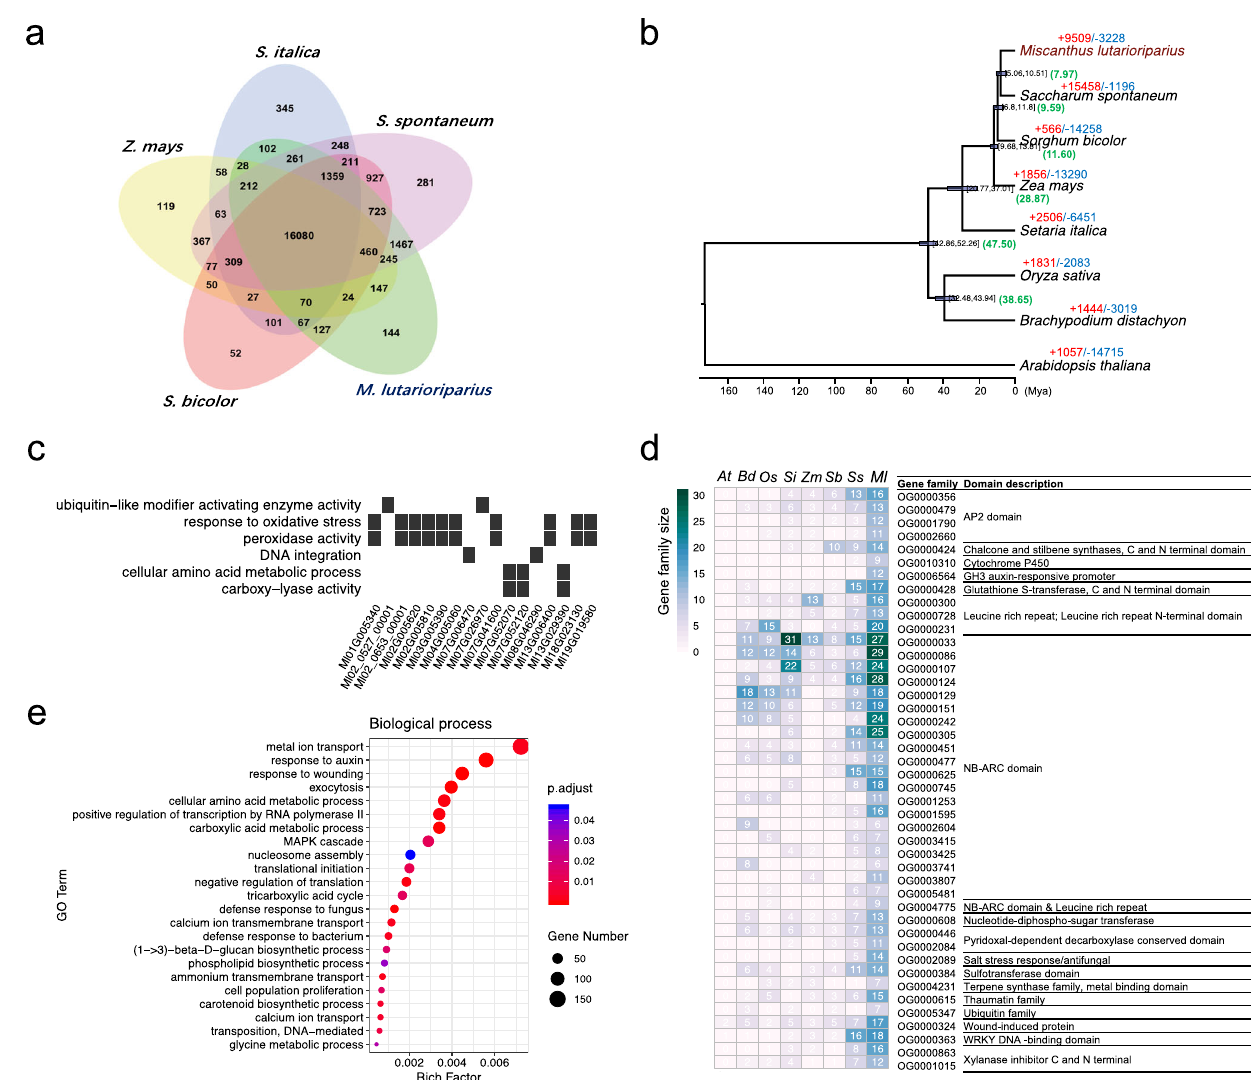
Fig. 4 Comparative genomics of gene family of M. lutarioriparius . a Venn diagram of shared orthologous genes ’ families among fi ve Panicoideae species genomes. b Inferred phylogenetic tree reconstructed using 122 single-copy ortholog genes shared by 8 species identi fi ed using OrthoFinder. Divergence timings were indicated using transparent blue bars at the internodes with 95% highest posterior density (HPD). The number of expanded and contracted gene families was marked with plus and minus ahead the digitals, respectively. c GO enrichment results of 144 M. lutarioriparius -speci fi c gene families. d Functional annotation for the rapidly evolving (expanded) gene families in M. lutarioriparius . Left panel shows the gene family size among 8 species and right panel shows the functional annotation for gene families. e GO enrichment results of 9509 expanded gene families of M. lutarioriparius (biological process category). Source Data are provided as a Source Data fi